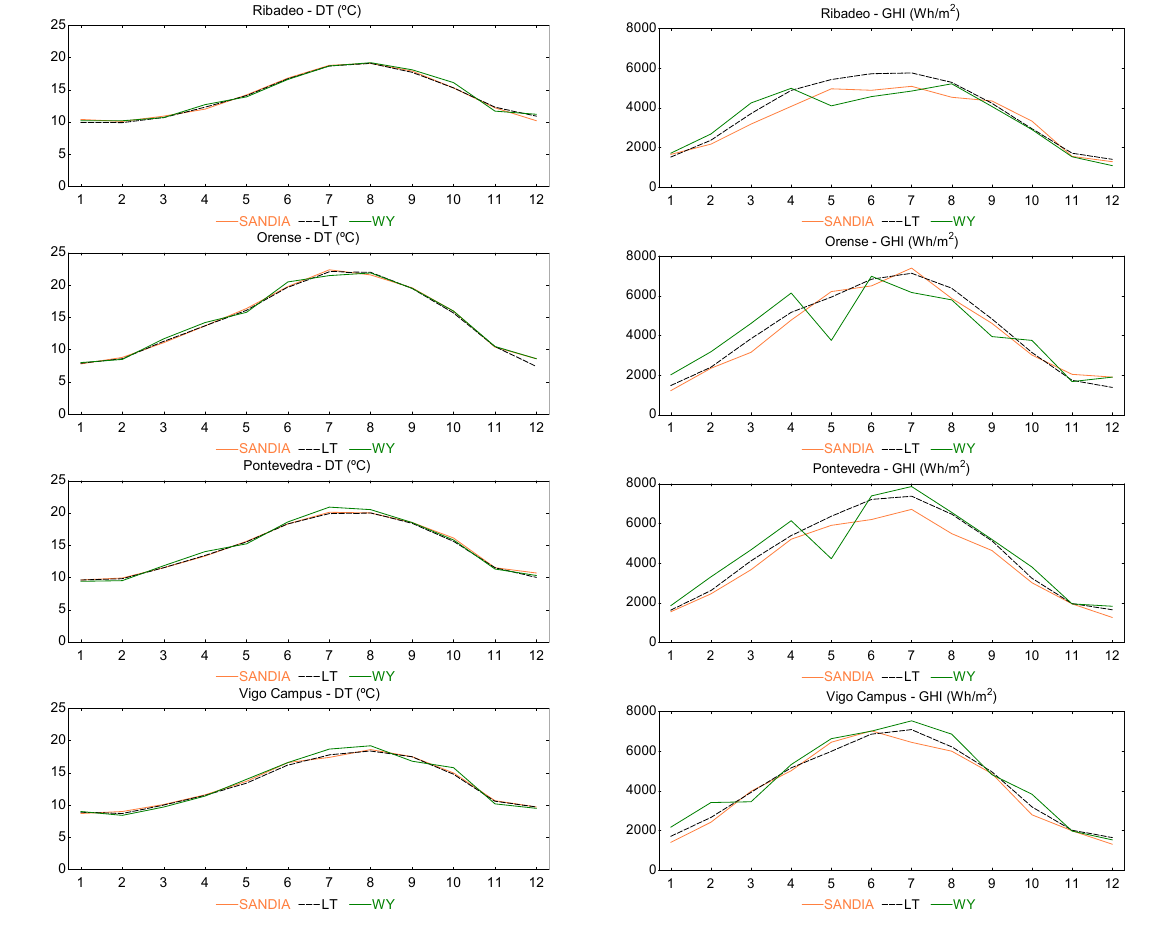
Figure 6. Comparison of the monthly evolution of dry bulb temperature (DT) and solar irradiation (GHI) for the 8 stations.